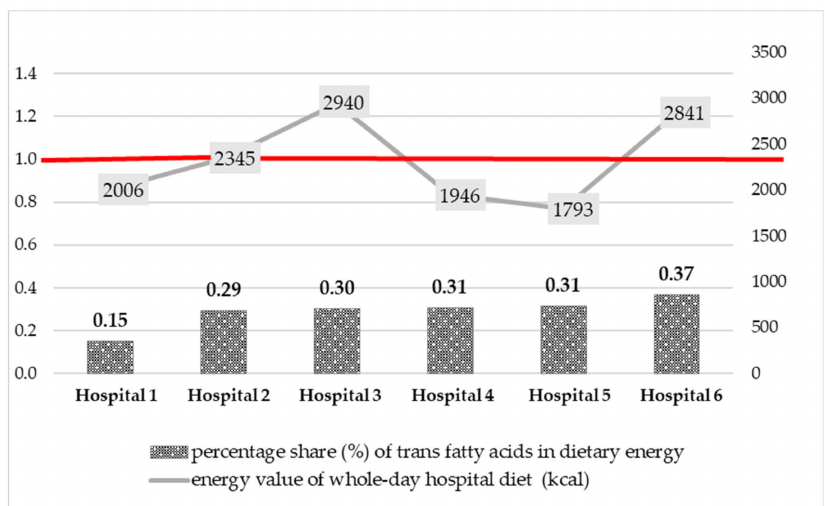
Figure 3. Comparison of the percentage share (%) of trans fatty acids in energy derived from the whole-day hospital diets with the WHO recommendation (1% of dietary energy, 1